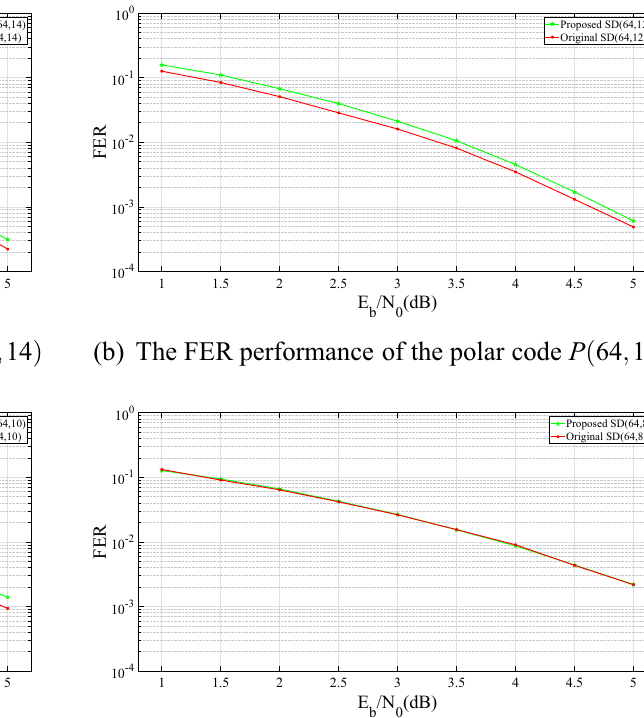
(d) The FER performance of the polar code P ( 64 , 8 ) Figure 4. The FER performance of the polar codes with N = 64 under different rates.